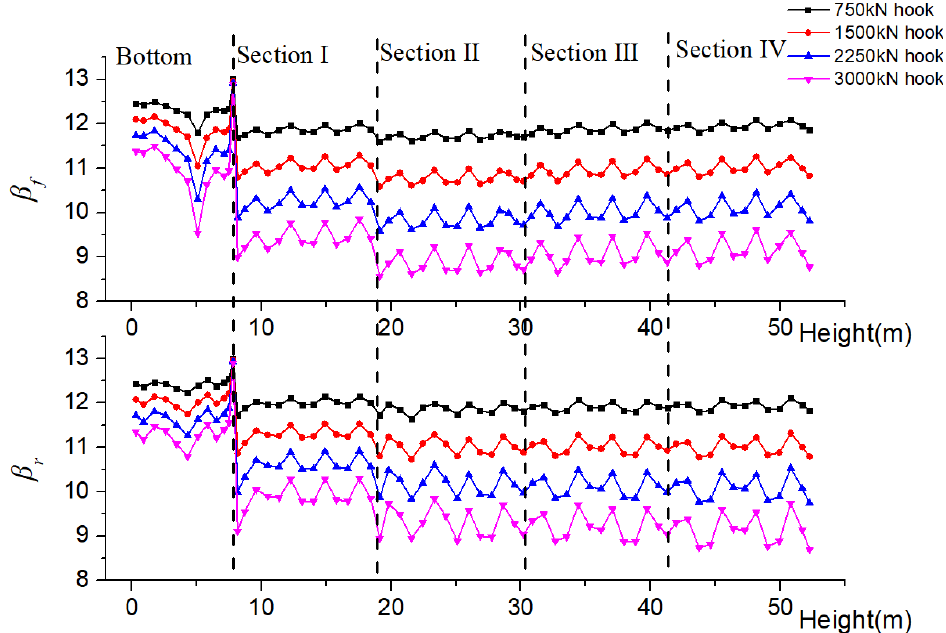
Figure 6. Variation curve of column reliability index along with height under different hook load.